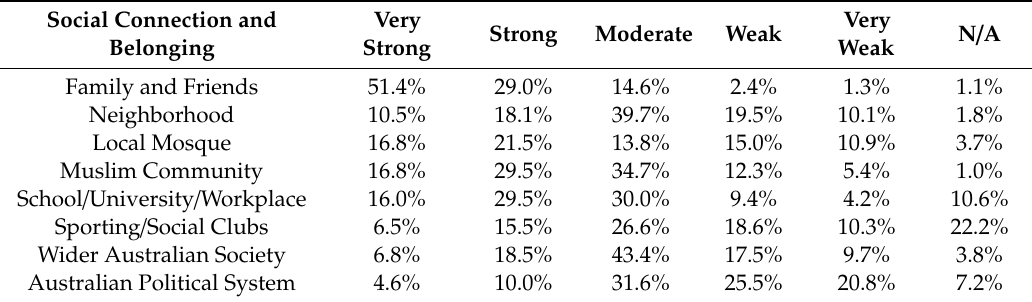
Table 5. Social connections and sense of belonging